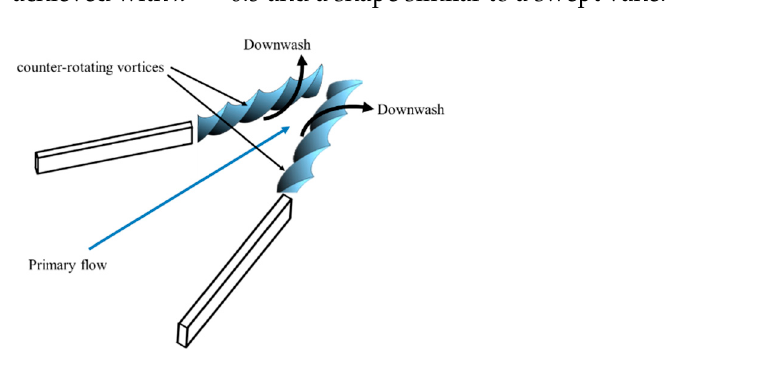
Figure 1. Flow structure of a counter-rotating VG with counter-rotating vanes. A common VG comprises rectangular thin-plate vanes. CRV VGs produce a stronger vortex downstream of the device than that of VGs with co-rotating vanes (CoV) [8] and have a uniform effect on the boundary layer flow. Ramp (or wedge) VGs are structurally robust and are eminently suited to applications in high-speed flows [9]. Leading edge separation produces a pair of weak trailing vortices. A strong primary vortex pair is shed from the slant top edges of a Ramp VG [10,11]. The vortex strength of a CRV VG is about twice as strong as that from a Ramp VG [3,12]. There are early lift-off vortices for a Ramp VG, which are less effective than a CRV or a CoV VG